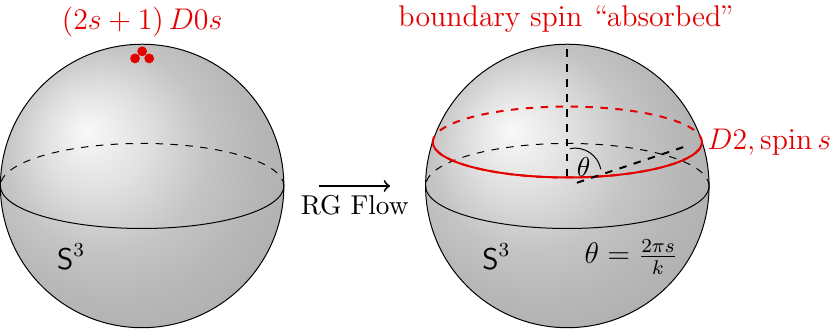
Figure 1 . A stack of 2 s + 1 D0 branes condense into a single brane of spin s at (cid:12)xed polar angle (cid:18) = 2 (cid:25)s . This process describes the absorption of an impurity by surrounding electrons in the k Kondo